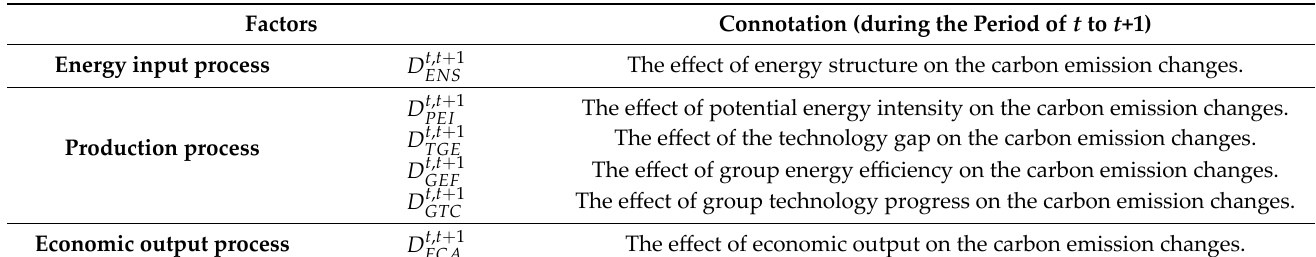
Table 1. Connotations of carbon emissions change influencing processes and